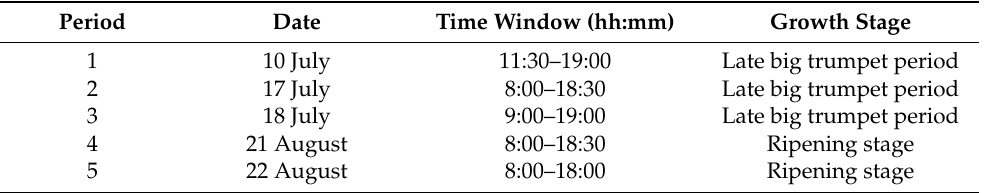
Table 1. Summary of the available day courses of radiometric measurements.